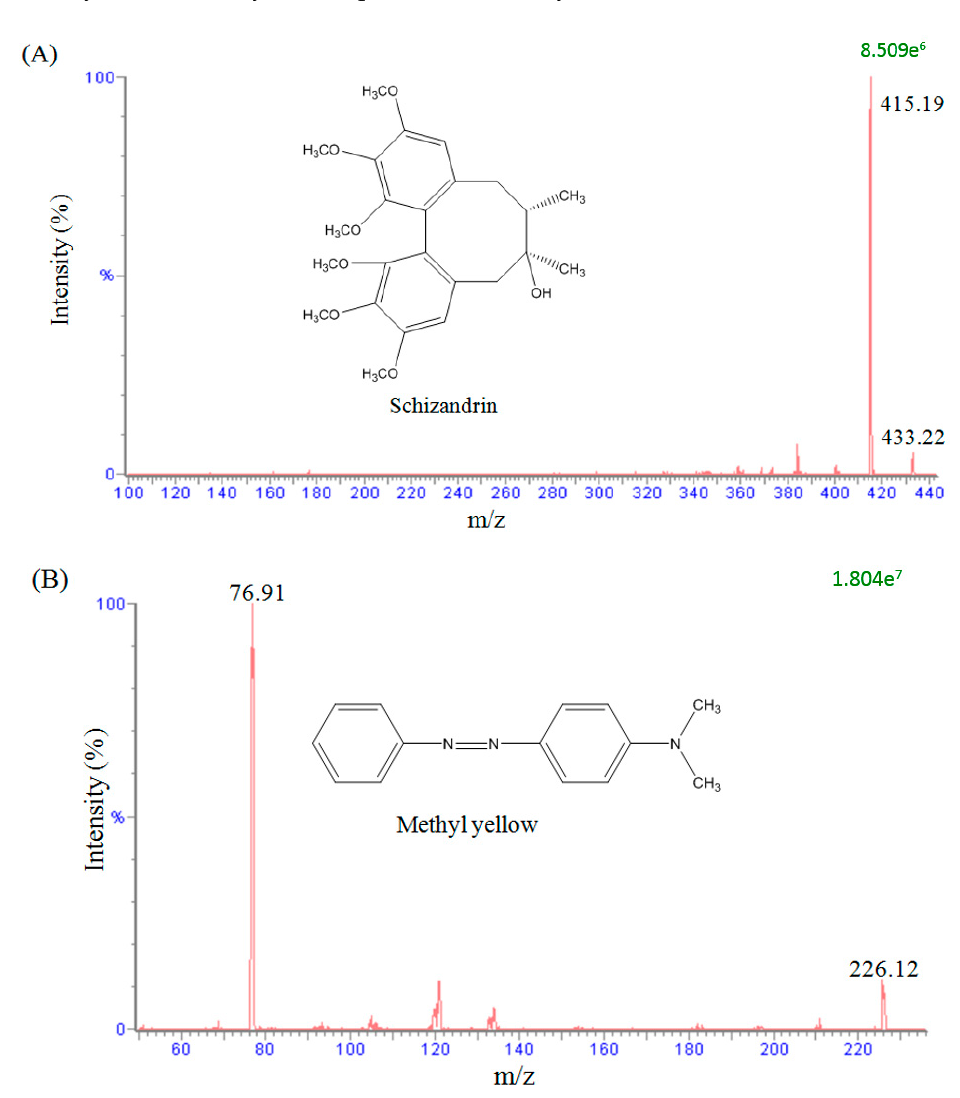
Figure 1. Representative product ion mass spectra and chemical structures of ( A ) schizandrin and ( B ) methyl yellow (internal standard).